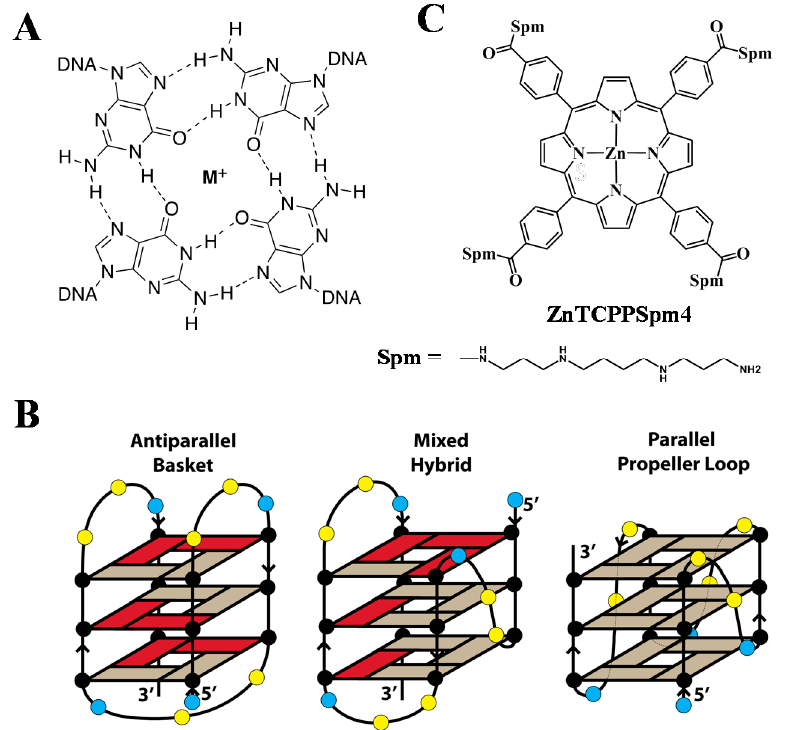
Figure 1. ( A ) Four guanines associate via Hoogsteen hydrogen bonding to form a G-tetrad. M + represents a central coordinating cation, such as Na + , K + , or NH 4+ . ( B ) Schematics of the physiologically-relevant structures of human telomeric DNA, dAGGG(TTAGGG) 3 . Grey and red rectangles represent guanines in anti and syn conformations. Adenines and thymines are represented as blue and yellow circles, respectively. Strand orientations are depicted with arrows. Mixed-hybrid conformation is that of Form 2. ( C ) Structure of ZnTCPPSpm4; the fifth axial water ligand attached to Zn(II) is not depicted for clarity of the image.